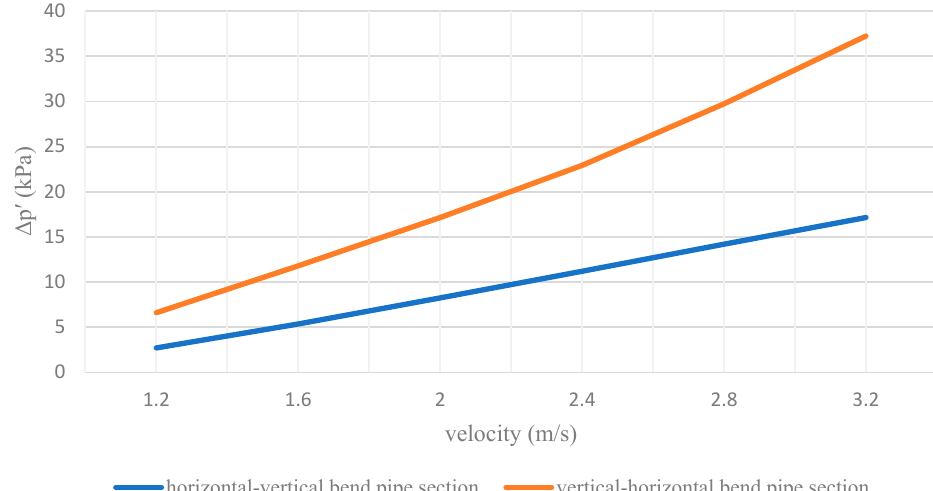
Figure 10. Pressure loss of two types of bend pipe section.